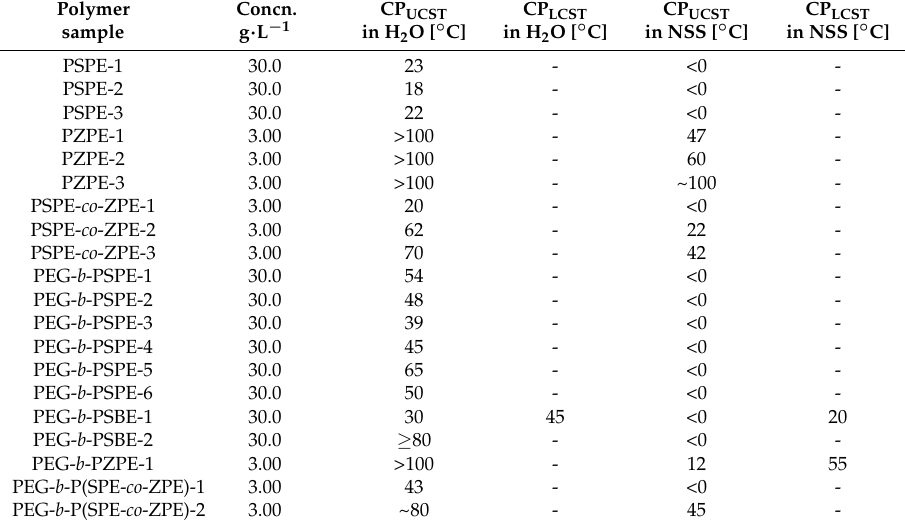
Table 3. Cloud points CP UCST and CP LCST of 0.3 or 3 wt % solutions of sulfobetaine homo-